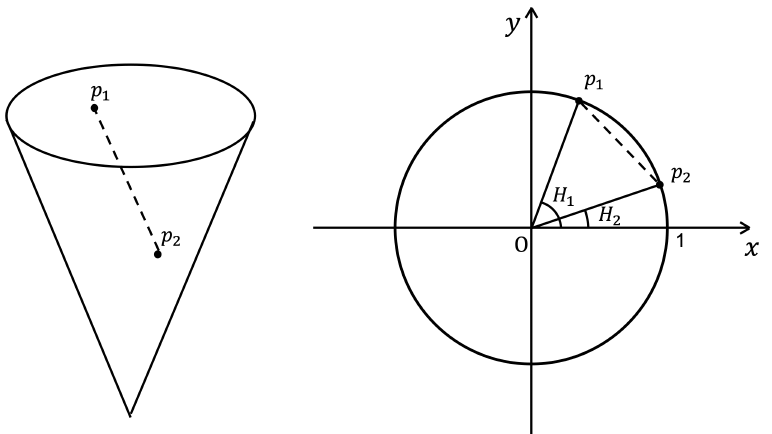
Figure 11. ( left ) Euclidean distance of two points on a HSV cone space. ( right ) Euclidean distance of two H points on a unit circle. Table 3. Test results with setting the maximum penalty over different degrees in the H loss function. d h ,1 ) . The values in bold indicate the best scores for The H loss function with degree θ is Min ( 360 θ each metric. L1